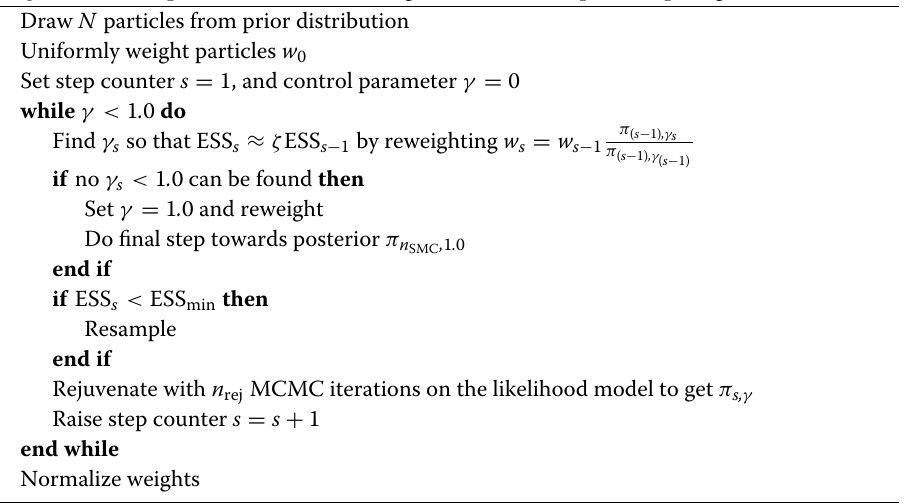
Algorithm 1 Sequential Monte Carlo algorithm with adaptive step